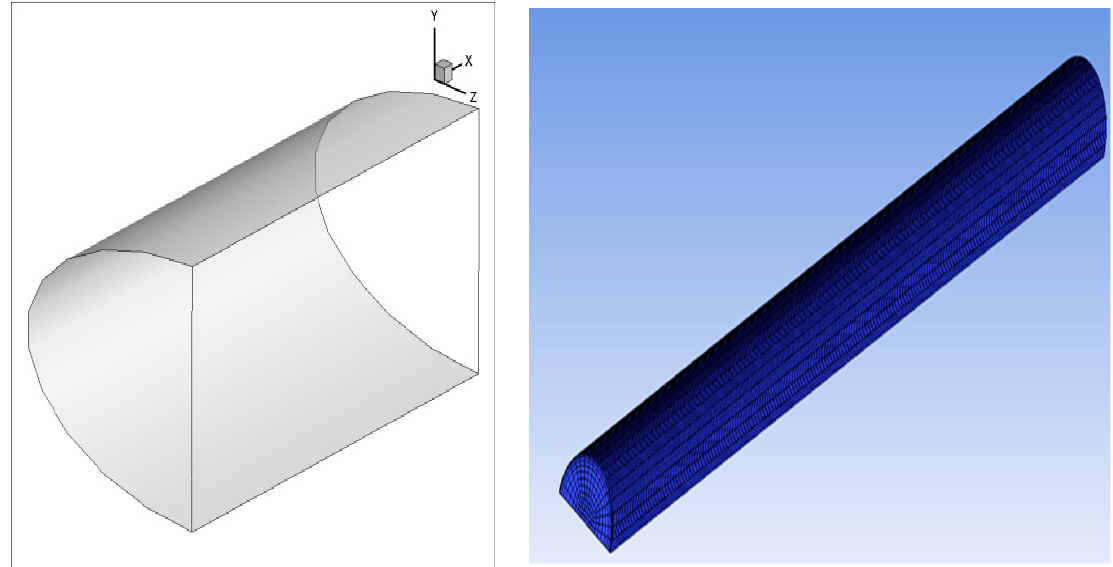
Figure 1. The propagation model of acoustic waves in the gas pipeline.